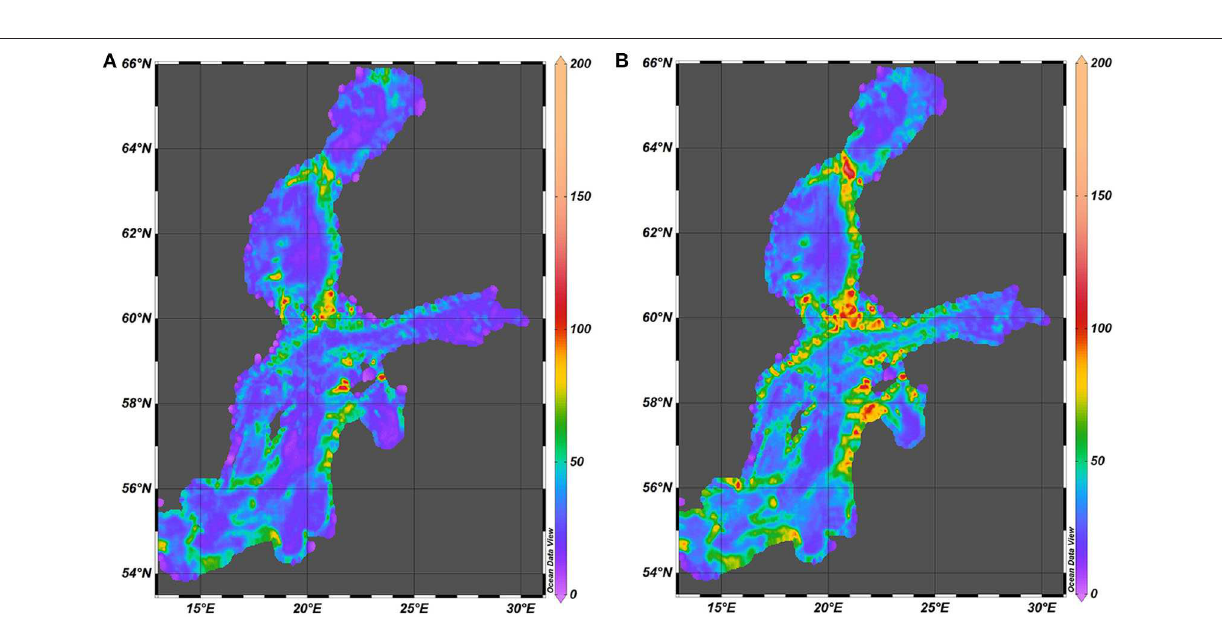
FIGURE 9 | Spatial distribution of the maximum nearbed speed (cm/s) in 1961–1965 (A) and in 2000–2005 (B)